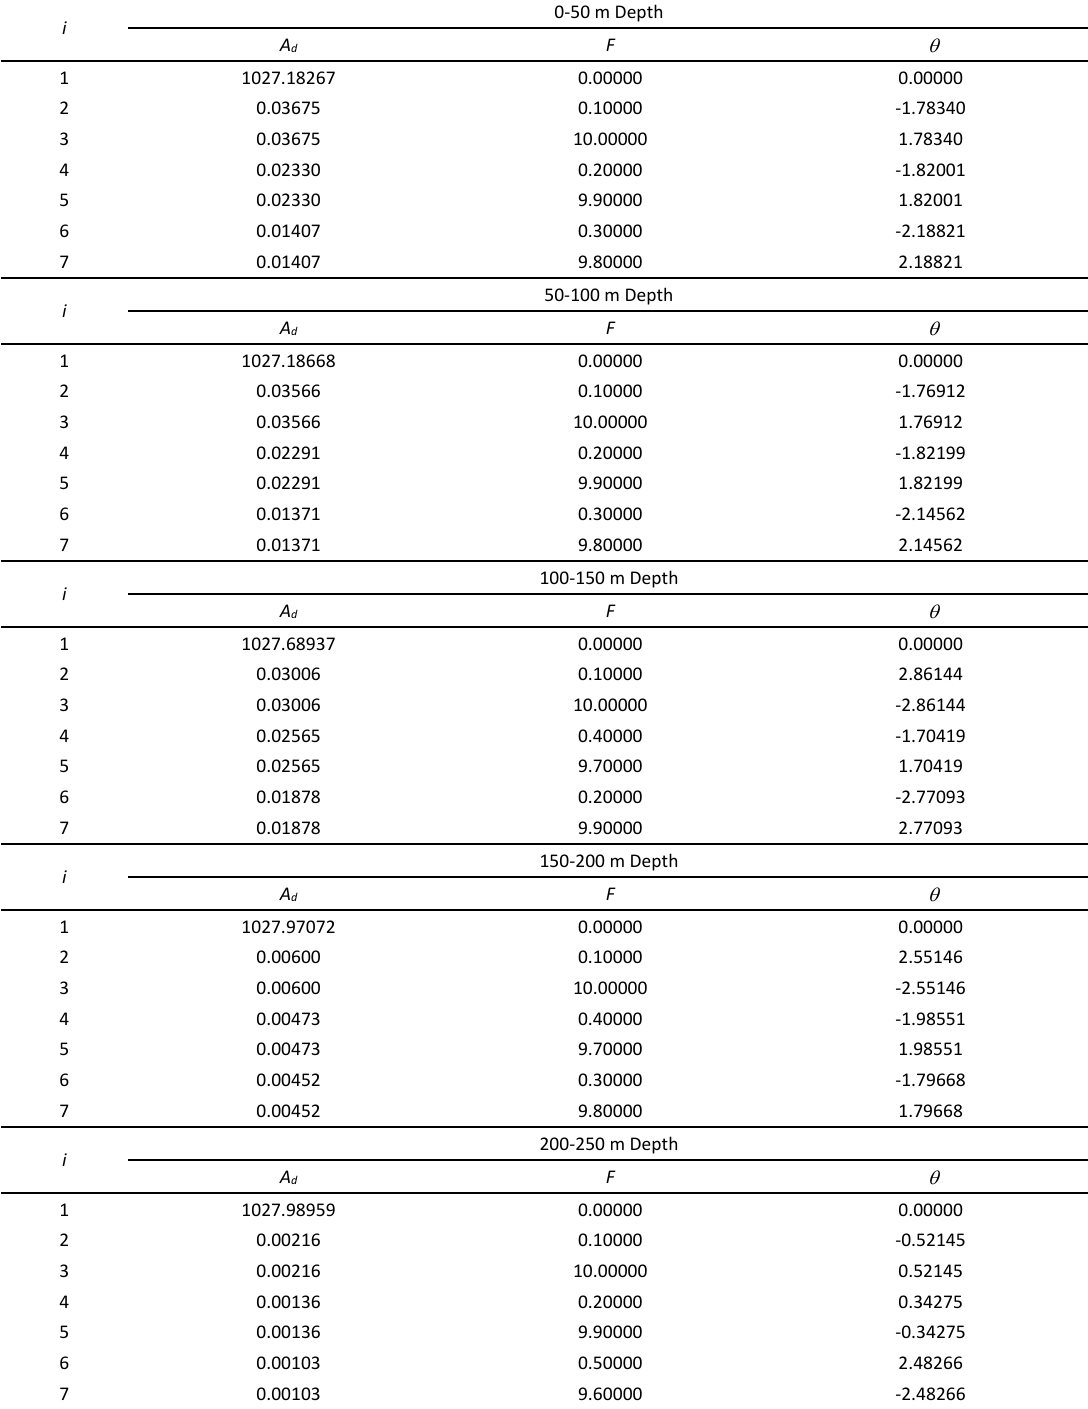
Table 3: Amplitude, frequency, and phase of the density values